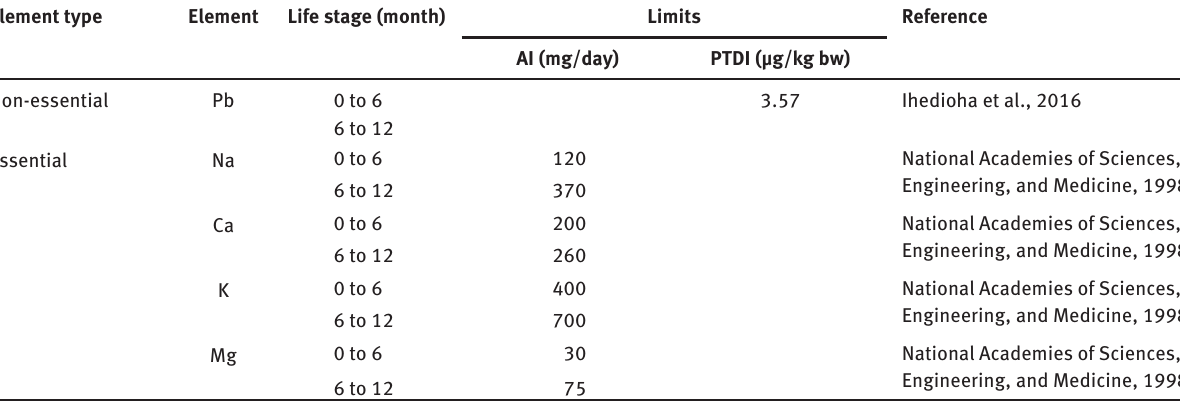
Table 7: Adequate intakes (AI) and provisional tolerable daily intake (PTDI) of elements Element